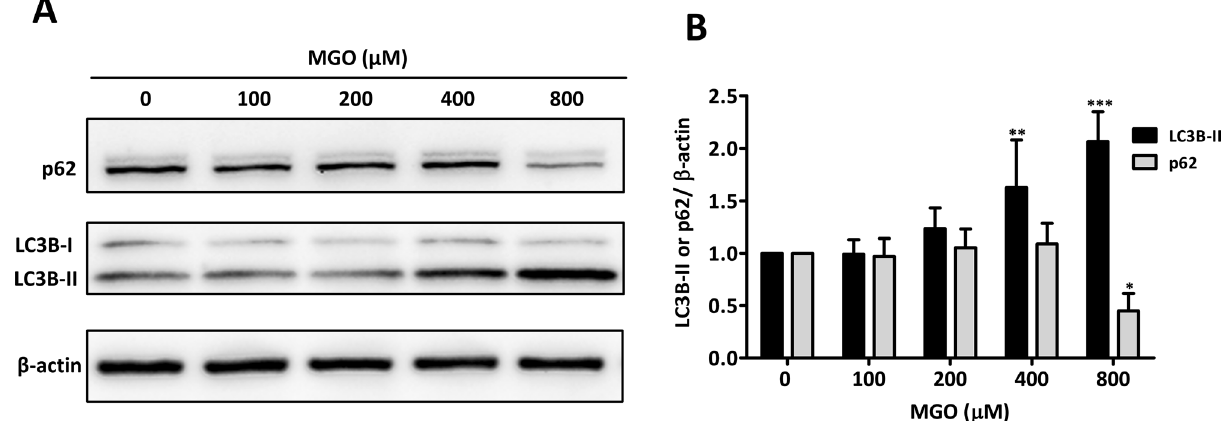
Figure 4. Induction of autophagy by MGO. ( A ) The cell lysates as described in Fig. 3 were also used to assess the expression of p62 and LC3B as markers for autophagy. The results of a representative experiment are shown. Displayed are the cropped blots and original blots are provided in Supplementary Fig. S4. ( B ) Quantification of p62 and LC3B-II was performed by densitometry as measure for autophagy. The results of 4 independent experiments are expressed as mean LC3B-II or p62/β-actin ratio ± SD. * p < 0.05, ** p < 0.01 and *** p < 0.001 vs. no